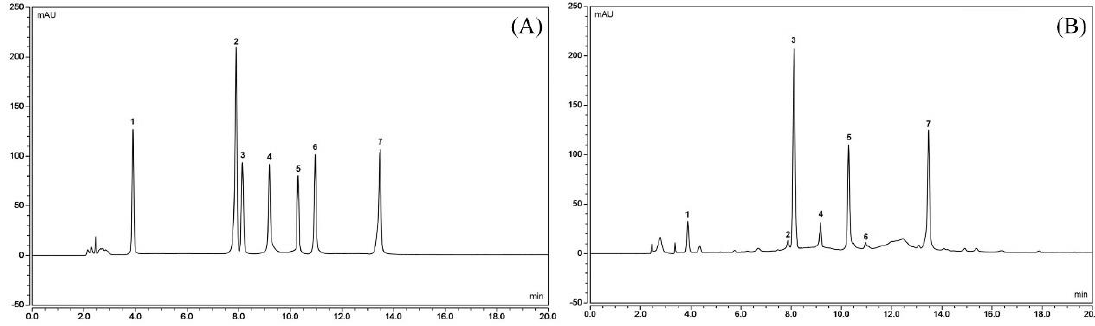
Figure 7. Polyphenol constituents of Liubao tea (PLT). ( A ) Standard chromatograms; ( B ) PLT chromatograms. 1: gallic acid; 2: catechin; 3: caffeine; 4: epicatechin (EC); 5: epigallocatechin gallate (EGCG); 6: gallocatechin gallate (GCG); 7: epicatechin gallate (ECG).